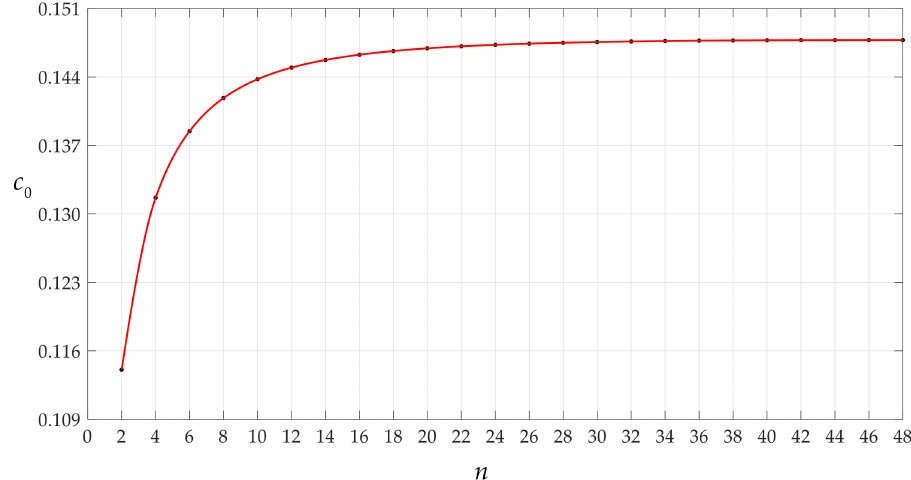
Figure 3. Variation of c 0 with n when q takes 0.003 MPa.